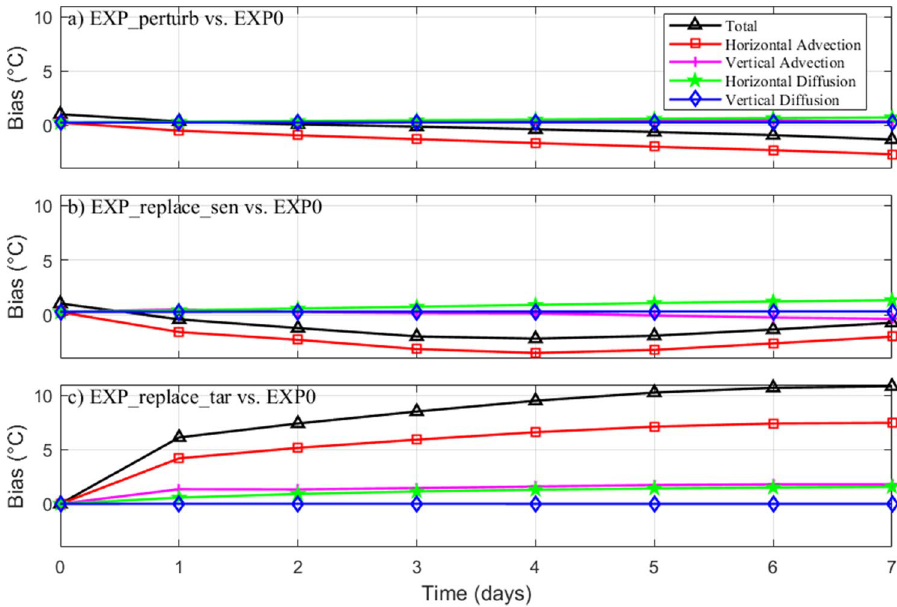
Figure 4. Temporal evolution of the mean vertically-integrated and regionally-averaged temperature biases during the prediction time based on the 20 sets of replace experiments induced by different processes in the target region for ( a ) EXP_perturb versus EXP0, ( b ) EXP_replace_sen vs. EXP0, and ( c ) EXP_replace_tar versus EXP0. Figures are plotted using MATLAB R2017a (http:// www. mathw orks.